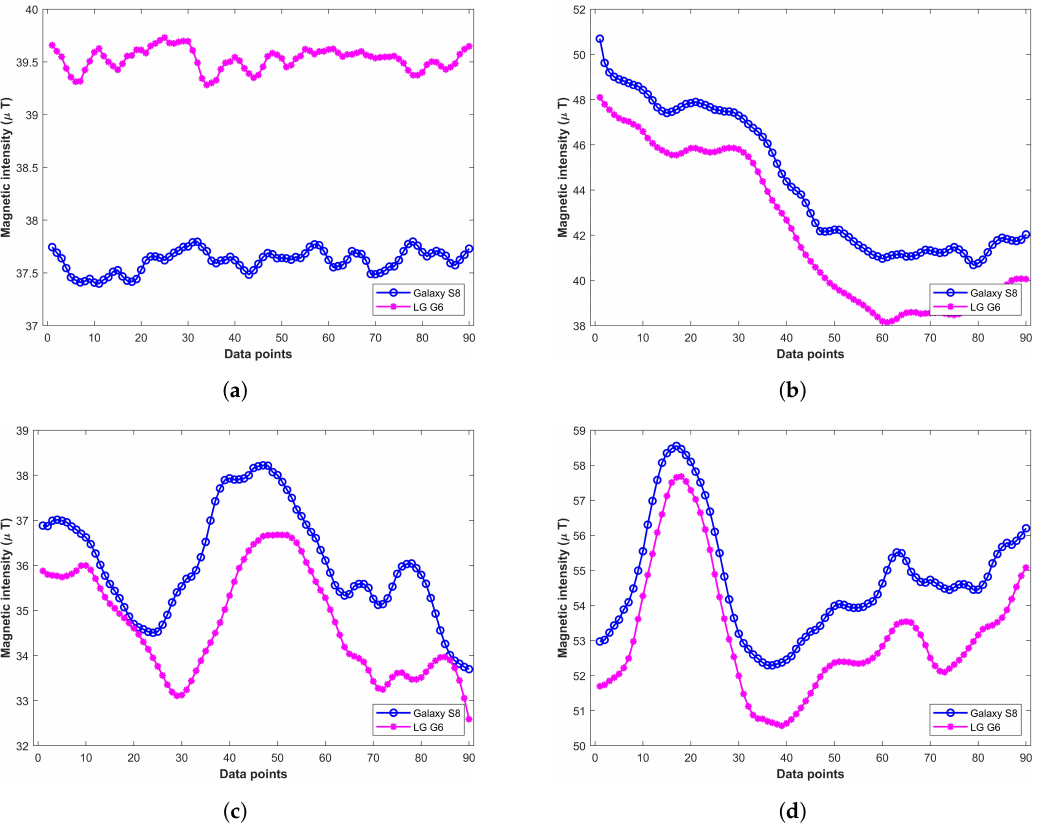
Figure 1. Magnetic readings from various smartphones at different indoor locations, ( a ) Location 1; ( b ) Location 2; ( c ) Location 3; ( d ) Location